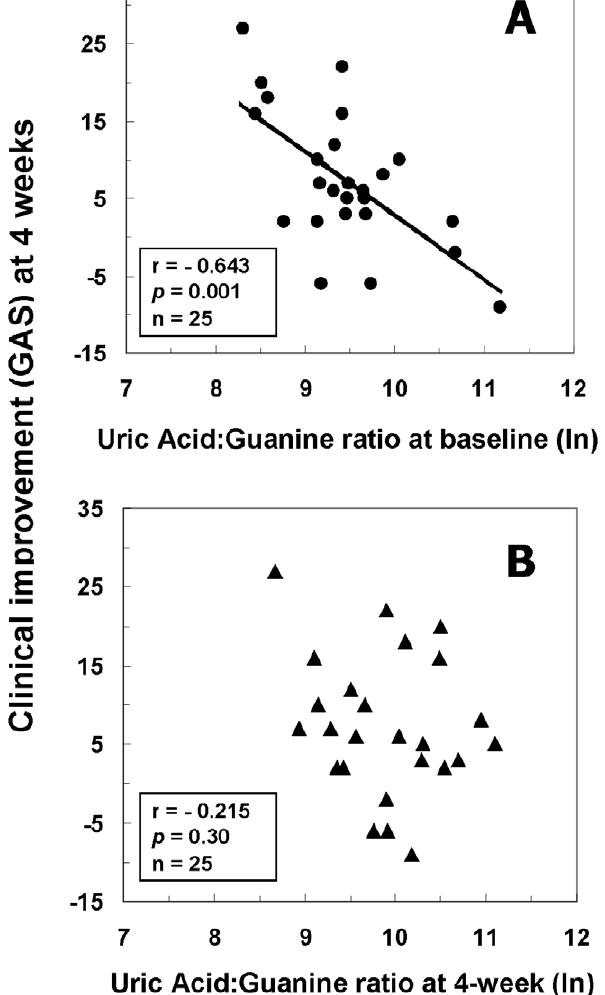
Figure 1. Associations between clinical improvement at 4 weeks and ratio of uric acid to guanine in first-episode neuroleptic-naı¨ve patients with schizophrenia at baseline (A) or at 4-week (B) after antipsychotic treatment. Abbreviations: GAS, Global Assessment Scale; ln, natural logarithm.